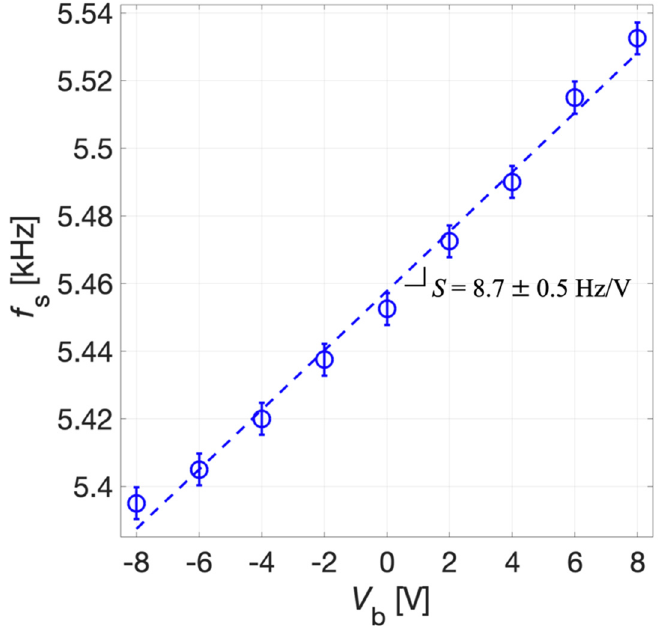
Figure 16. Measured series resonant frequency f s (circles) and linear fitting (dotted line) as a function of V b . The error bars extend one standard deviation σ on each side of the experimental data.